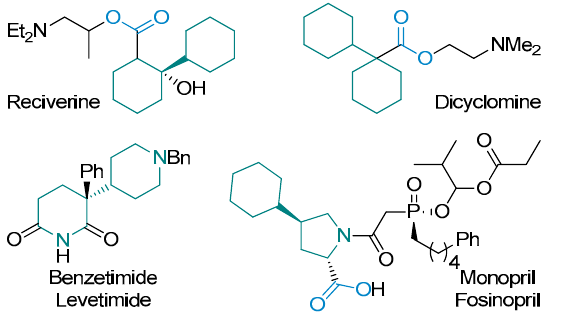
Figure 1. Pharmaceutically relevant examples of pharmaceuticals based on the scaffold with isolated (hetero)aliphatic rings.